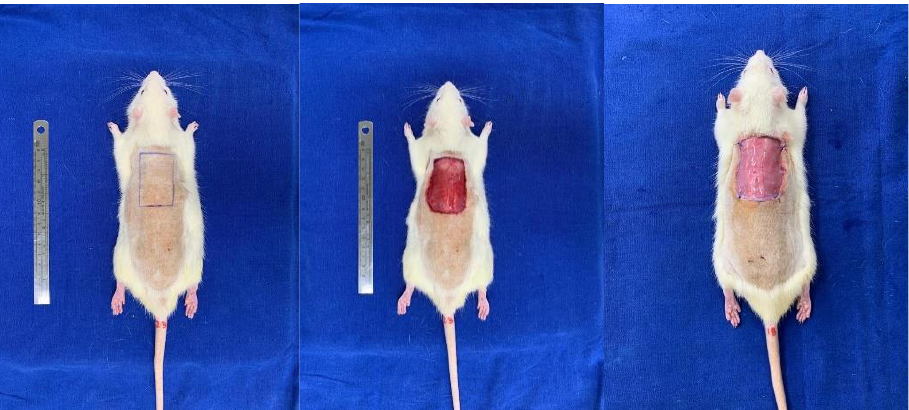
Figure 2. Flap skin exposition with a 30 × 50 mm (150 mm 2 ) defect made with a